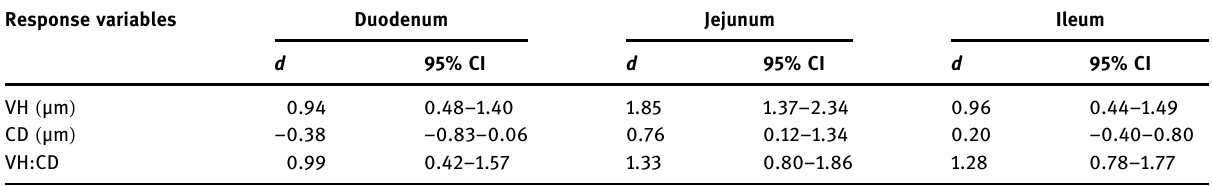
Table 3: Histomorphometric changes in the intestine of broiler chickens fed Bacillus - supplemented diets Response